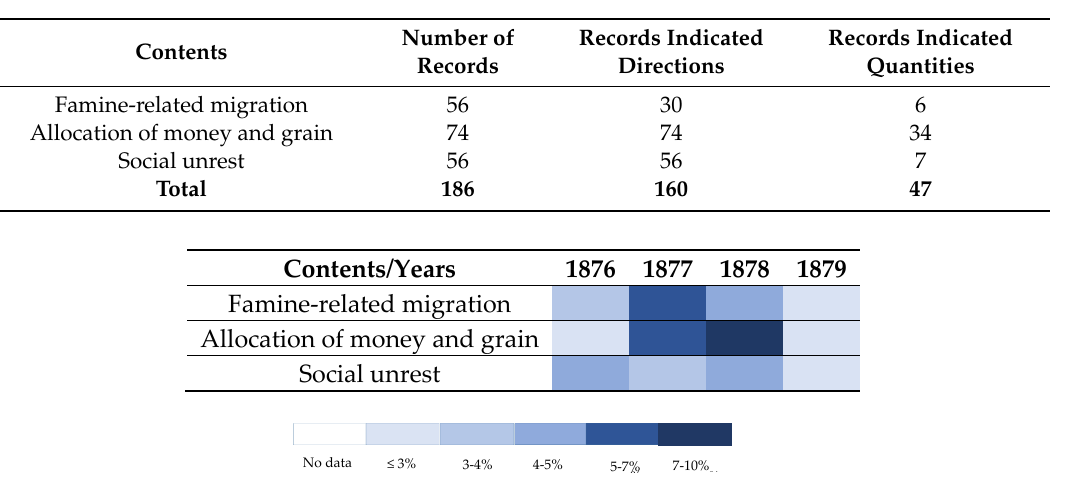
Table 2. Information on sources of the data about the North China Famine of 1876–1879.